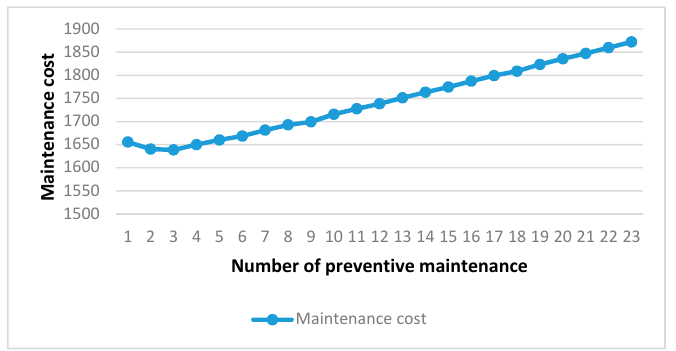
Figure 2. Average total cost of the maintenance according to P .